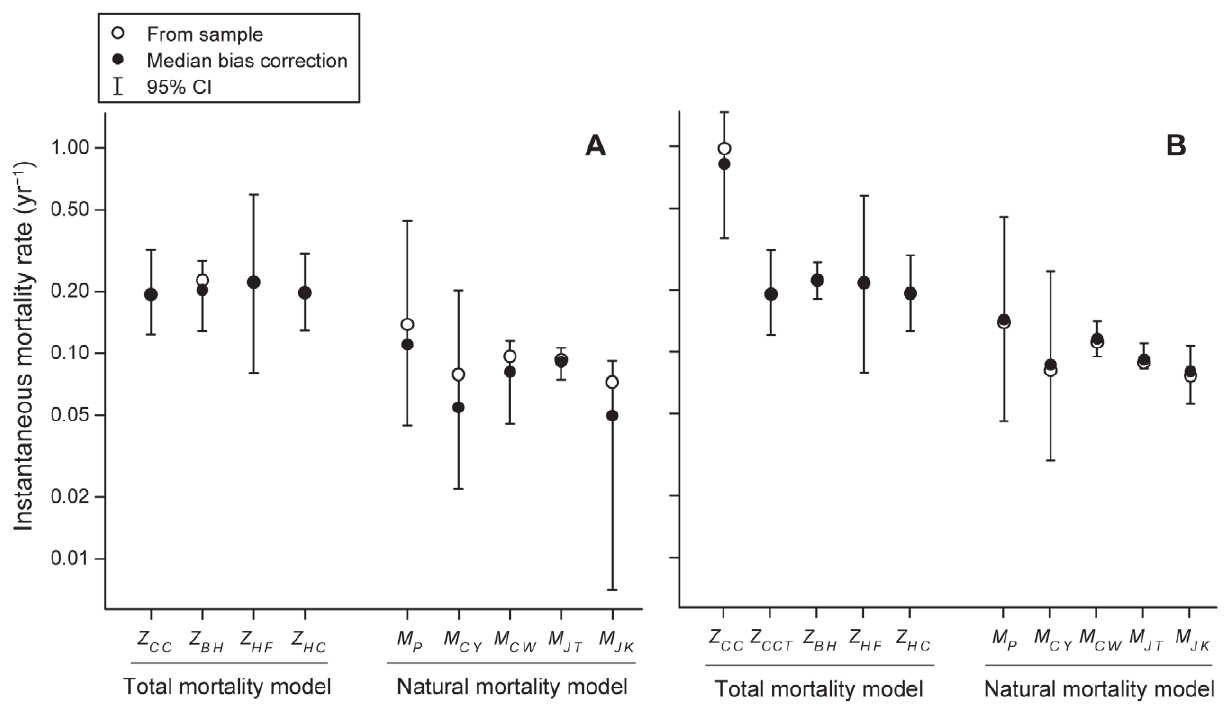
Figure 2. Estimates of natural and total mortality rate for two reef shark species. These estimates were calculated for (A) T. obesus and (B) C. amblyrhynchos on the Great Barrier Reef. For each method, an open circle indicates the (raw) sample estimate, which was obtained using maximum likelihood parameter estimates from analysis of the empirical data, a closed circle indicates the bootstrap bias-corrected estimate, and whiskers indicate 95% bias-corrected, accelerated (BCa) bootstrap confidence intervals. For methods that produced age-specific estimates of mortality rate ( Z CC for C. amblyrhynchos , and M- CW for both species), an age-averaged mortality rate is shown (i.e., weighted according to the fraction of the population at each age in the stable age distribution). Note that the vertical axis is plotted on